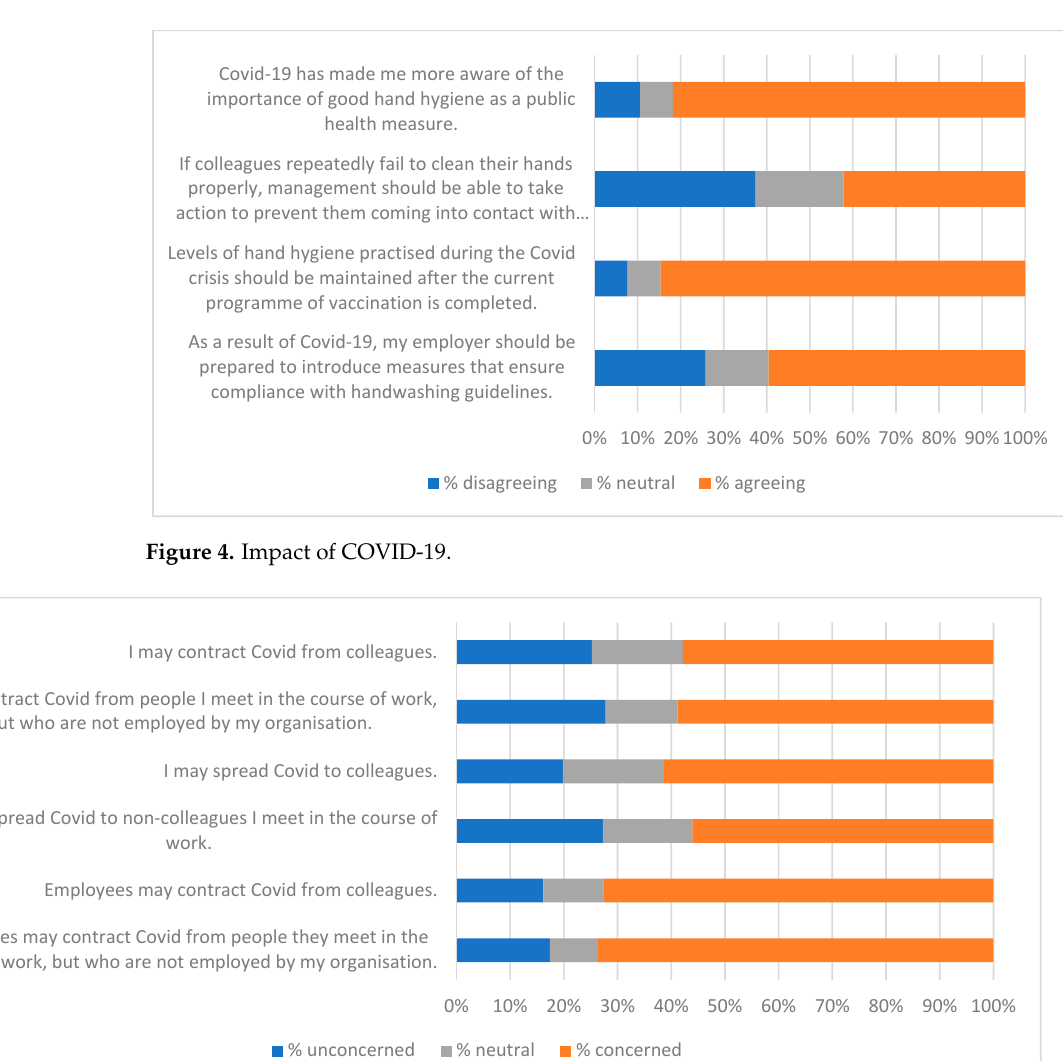
Figure 3. Promoting HH.